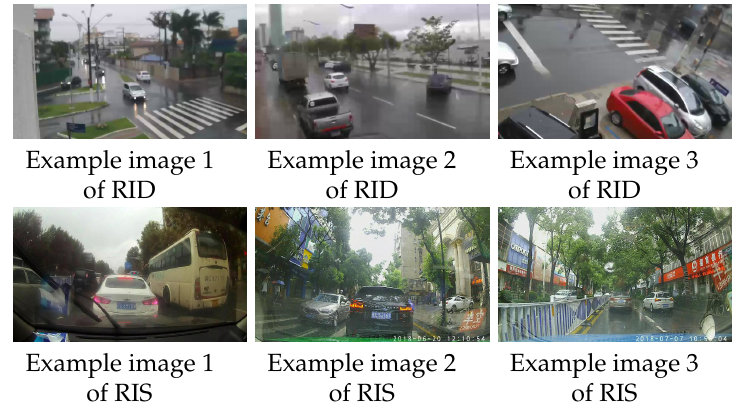
Figure 4. Examples of RID and RIS images [38].